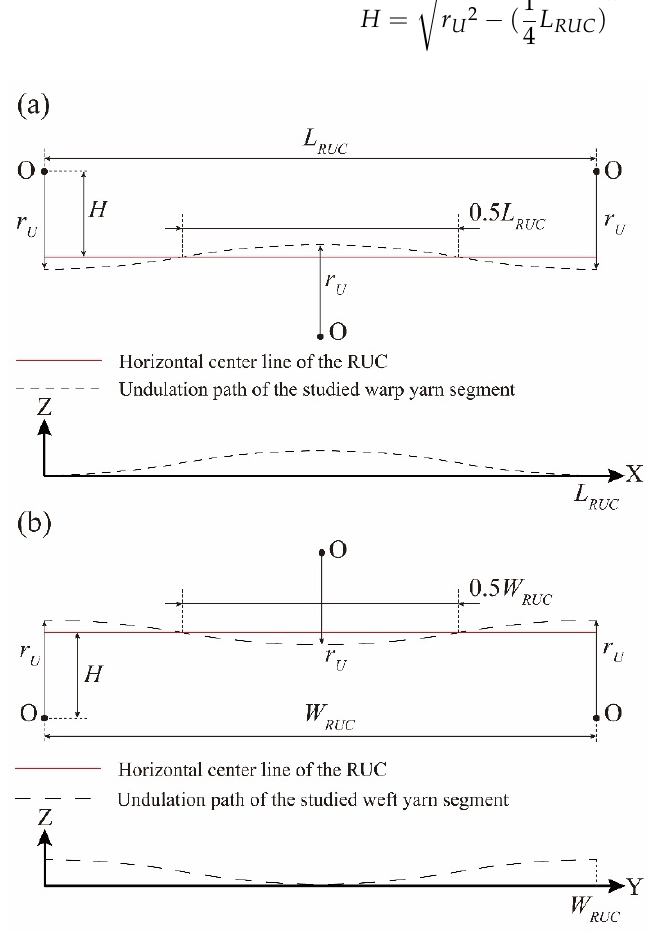
Figure 3. The undulation paths of the studied yarn segments: ( a ) the undulation path of the warp yarn segment; ( b ) the undulation path of the weft yarn segment.